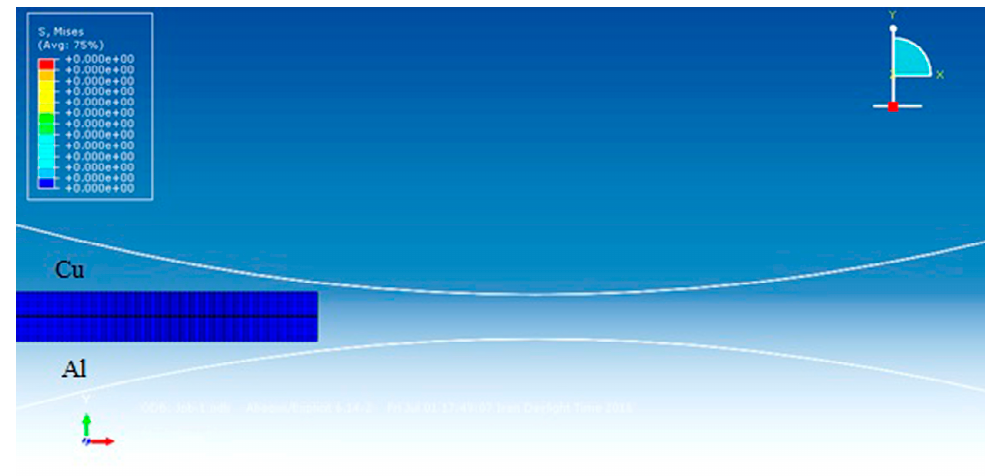
Figure 5. Geometry and Finite Element (FE) meshing of the bimetallic strip rolling.